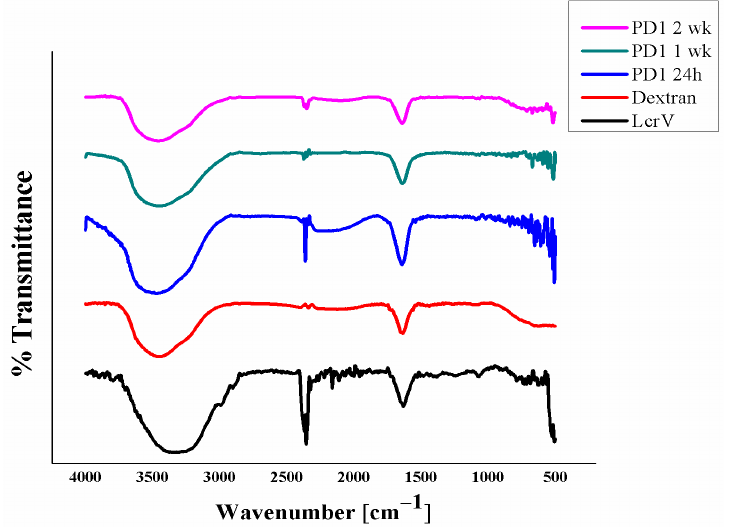
Figure 4. FT-IR spectra of pure protein, polymer, and protein formulation PD1 (after different storage intervals).